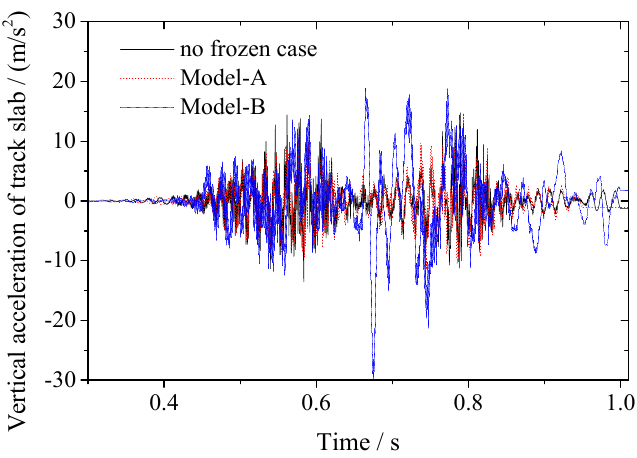
ff erent models.